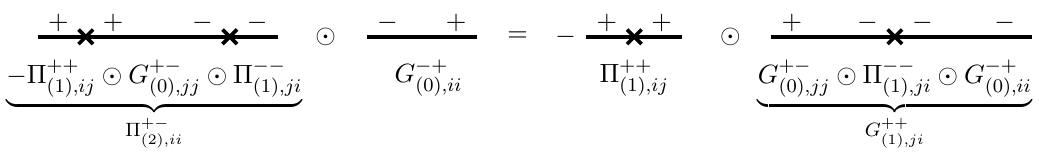
(cid:12) G + − = − Π −− (cid:12) G −− , with (cid:12) denoting (2) ,ii (0) ,ii (1) ,ij (1) ,ji